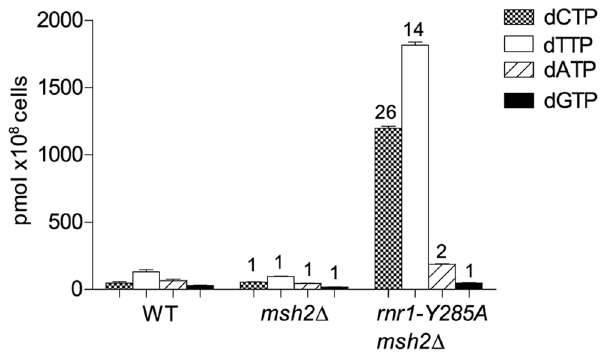
Figure 1. dNTP pools of the strains with the imbalanced dNTP pools. Numbers above columns show the factor increase over wt. Error bars show Standard Error of Mean.